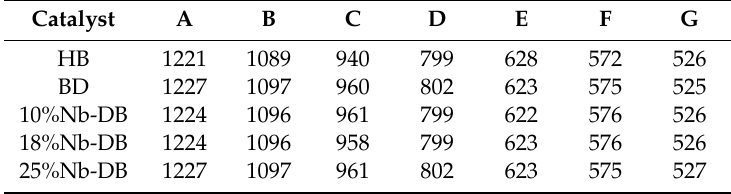
Table 2. Main wavenumber (cm − 1 ) bands identified in the FTIR of the catalysts. Catalyst A